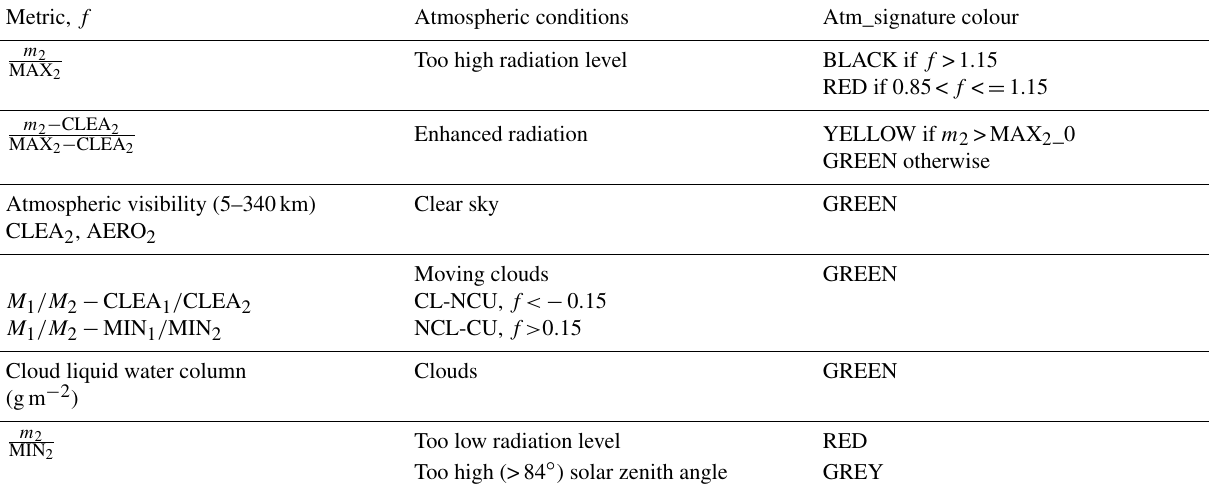
Table 3. Categories of atmospheric conditions estimated by the QA tool AtmosphericSignature on the basis of comparison of the measured and simulated solar UV irradiance spectrum. Metrics used for the estimation and determination of the associated colour for the Atm_signature flag. Symbol m denotes the measured irradiance. Symbols MIN, MAX, AERO, and CLEA denote the irradiance simulated for the corre- sponding scenarios. Subscripts 1 and 2 refer to the wavelength bands used for comparison (measured vs. modelled) in the lower and upper part of the UV spectral region,